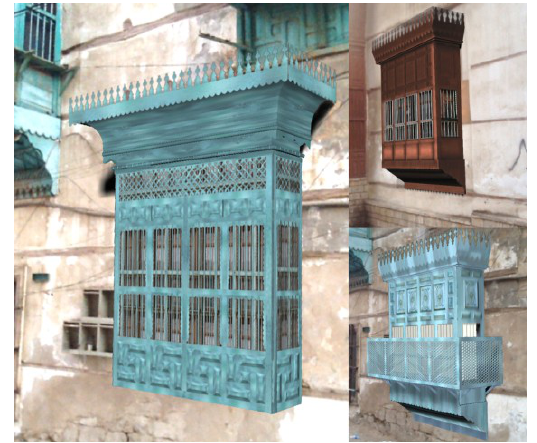
Figure 10.The Using of Augmented Reality (AR) technology.